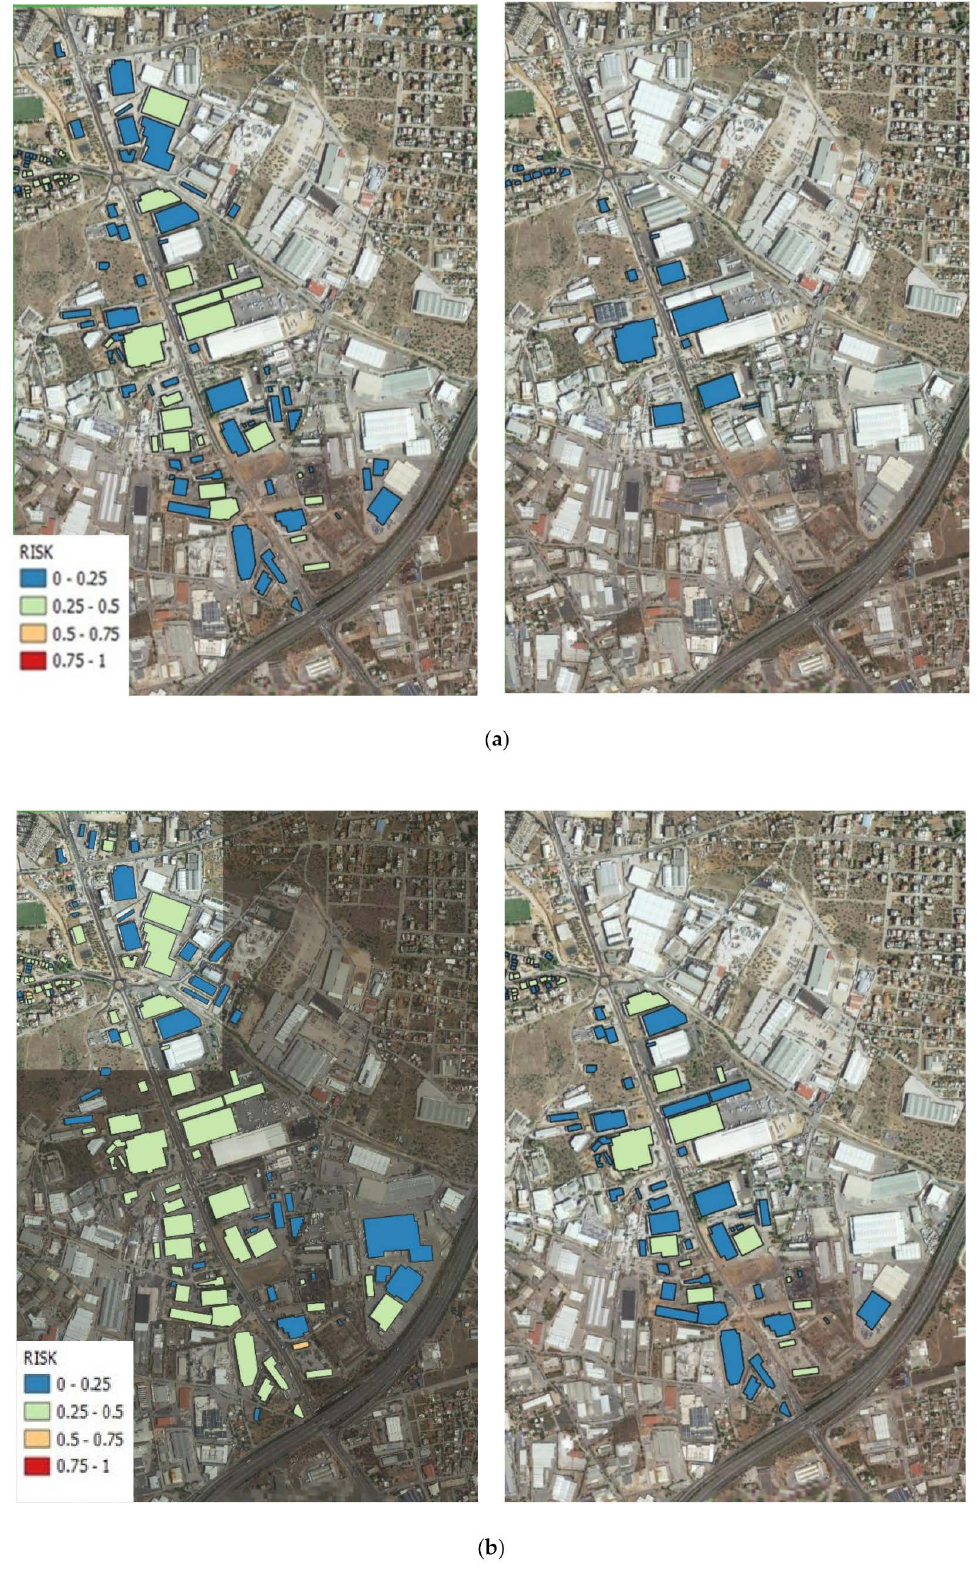
Figure 14. Flood risk in the industrial area for 4 indicative scenarios: ( a ) Scenarios S20-06 ( left ) and W20-06 ( right ) for T = 20 y and t = 6 h. ( b ) Scenarios S200-18 ( left ) and W200-18 ( right ) for T = 200 y and t = 18